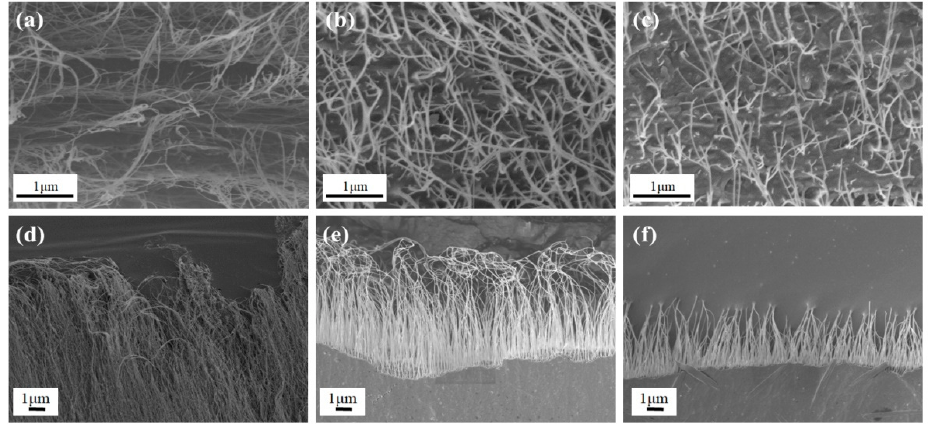
Figure 3. SEM images of the fracture morphologies of CNT film ( a , d ), CNTF/MPC@1000 ( b , e ), and CNTF/MPC@1300 ( c , f ).